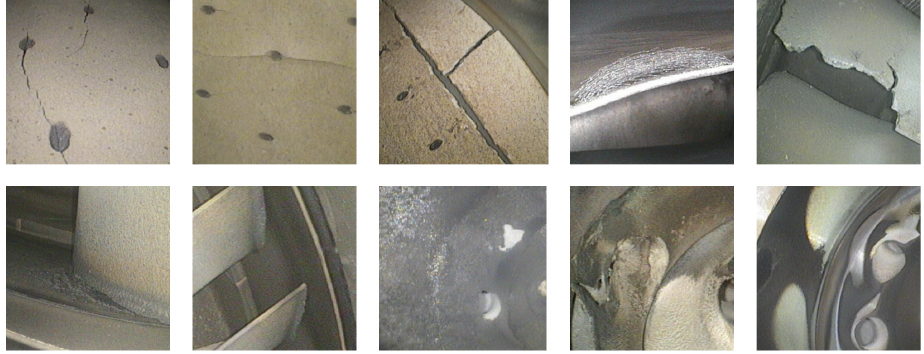
Figure 4. Partial